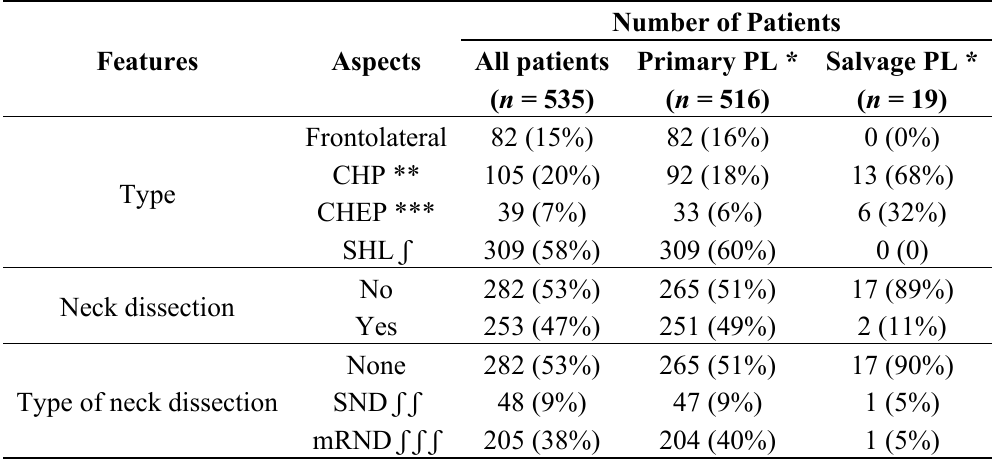
Table 2. Details of